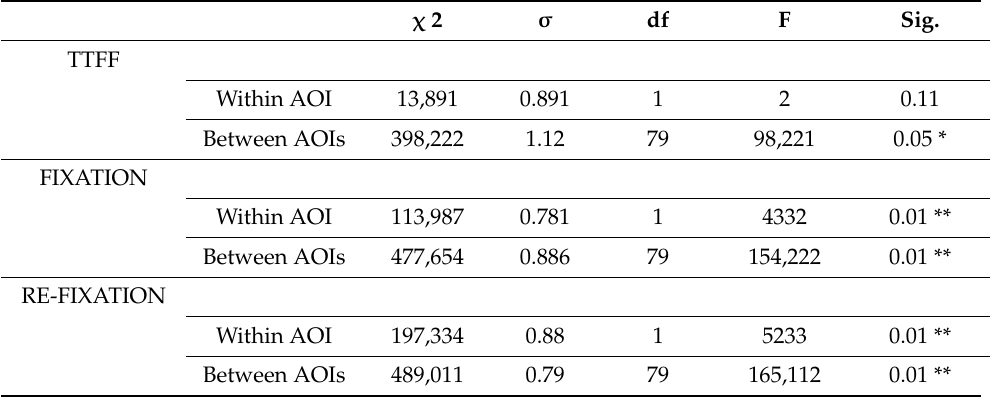
Table 2. AOI 4 ANOVA test S2